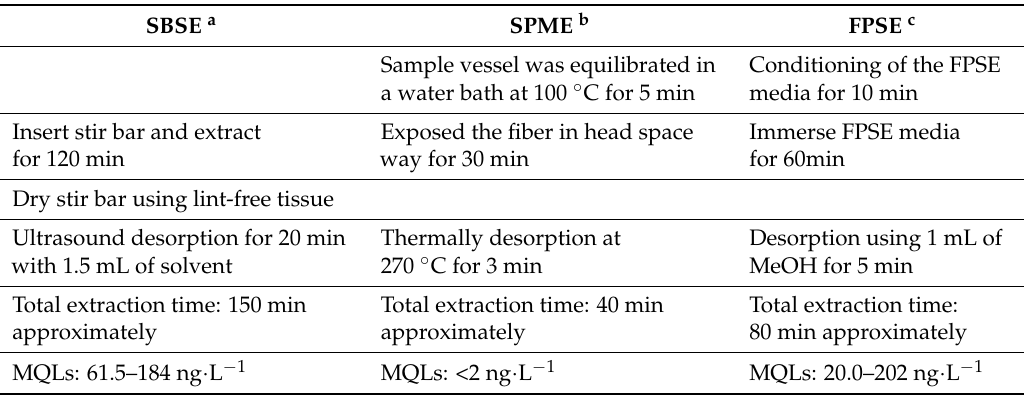
Table 3. Comparison of microextraction techniques used to extract BUVSs from sewage